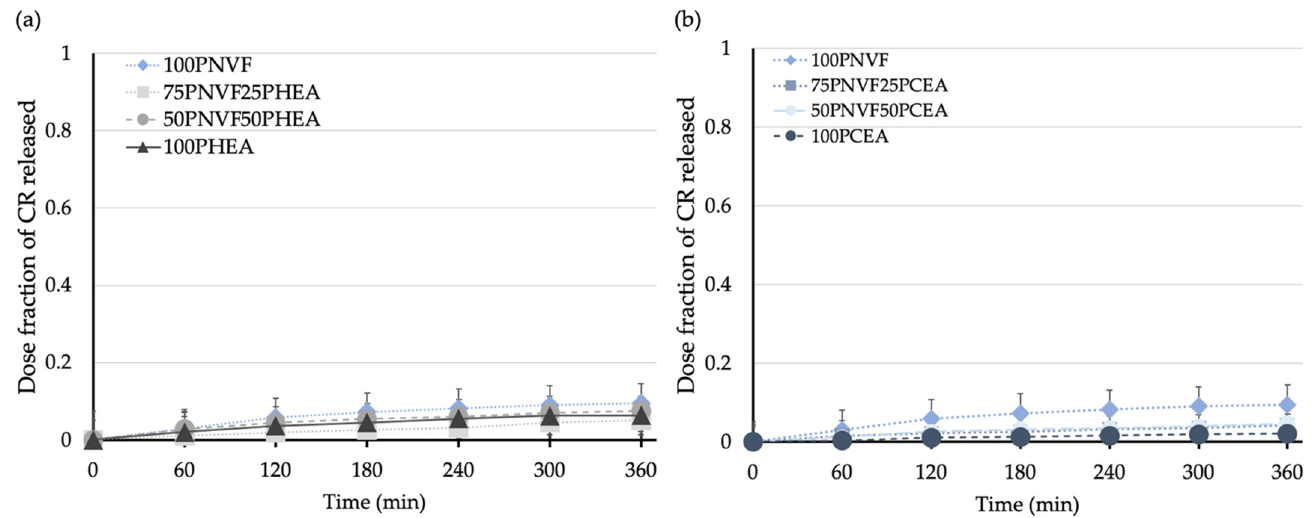
Figure 8. Release profiles of ( a ) NVF and HEA hydrogel series and ( b ) NVF and CEA hydrogel series with 0.0001M Congo red solution.